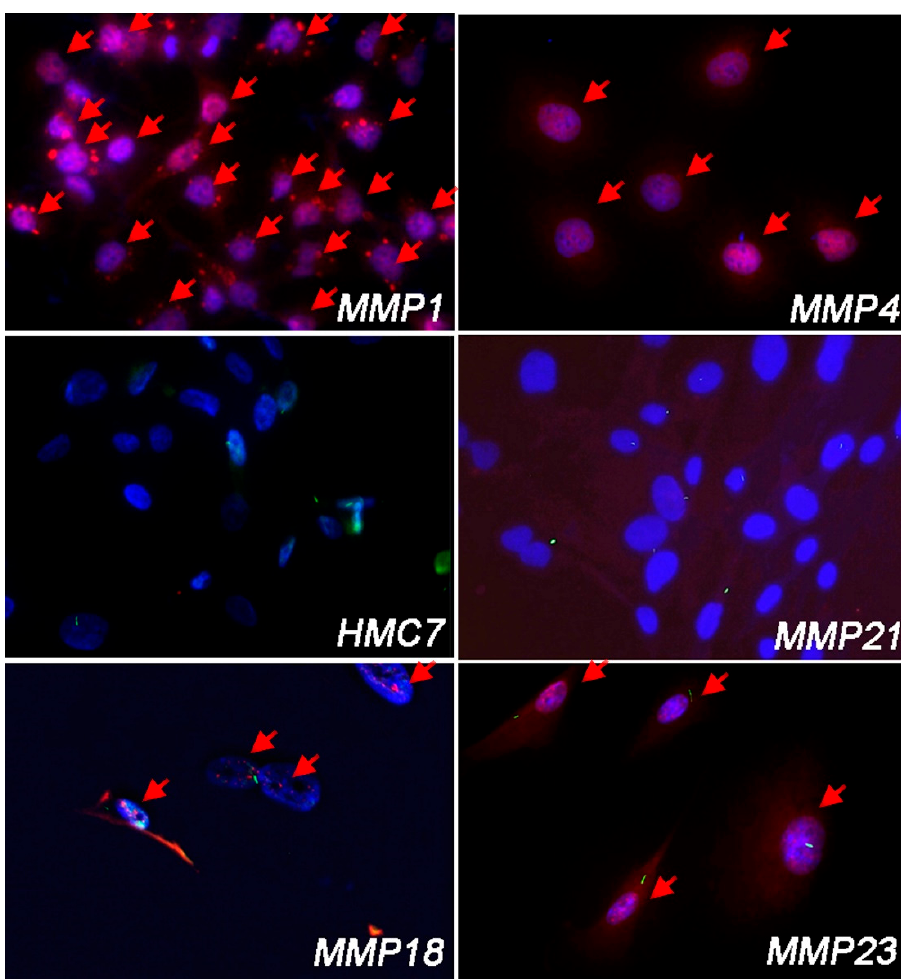
Figure 4. IF analysis of nuclear GLI1 in MPM cell lines and HMC7 normal mesothelial cells. Hh/GLI1 signaling is activated in PC-negative cells MMP1 and MMP4, and in PC-positive cell lines MMP18 and MMP23. Red: GLI1; green: Arl13b; blue: DAPI. The arrows indicate the cells with nuclear GLI1. Magnification 20×.